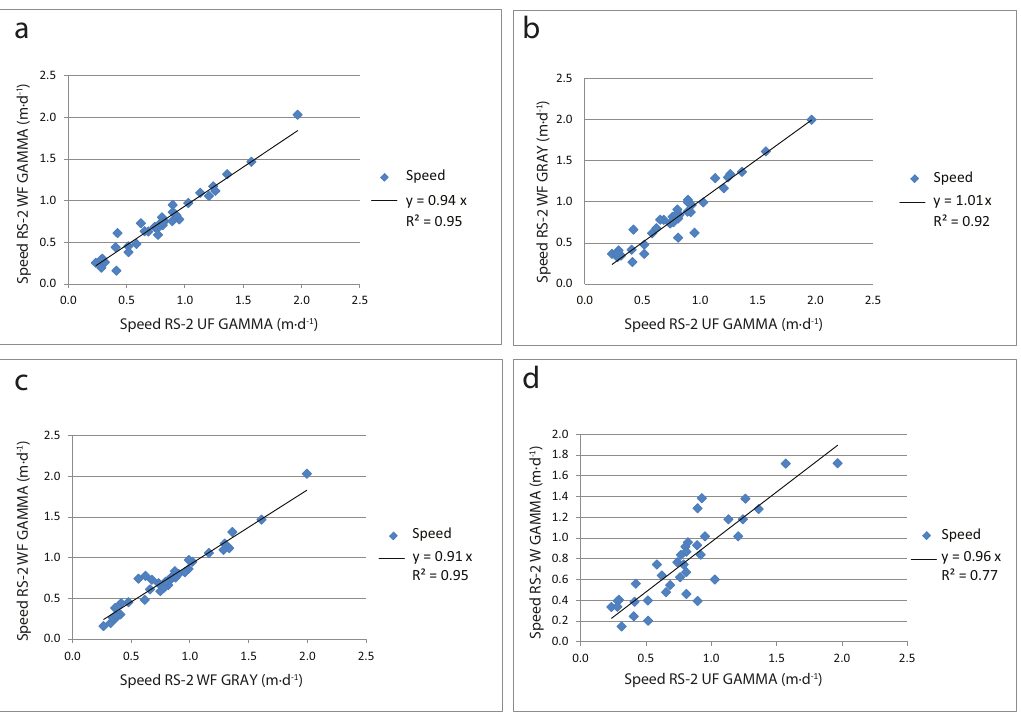
Figure 10. Validation of glacier speed on Kronebreen: Speed extracted from SAR maps on a 1 km point grid: ( a ) RS-2 UF GAMMA vs. RS-2 WF GAMMA; ( b ) RS-2 UF GAMMA vs. RS-2 WF GRAY; ( c ) RS-2 WF GRAY vs. RS-2 WF GAMMA; and ( d ) RS-2 UF GAMMA vs. RS-2 W GAMMA.